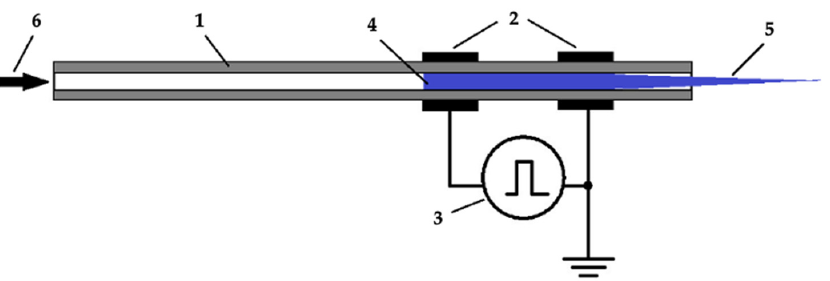
Figure 1. Electrode system of plasma-jet-based DBD: 1—glass pipe, 2—ring electrodes, 3—pulsed power supply, 4—gas discharge, 5—plasma jet, 6—gas flow.